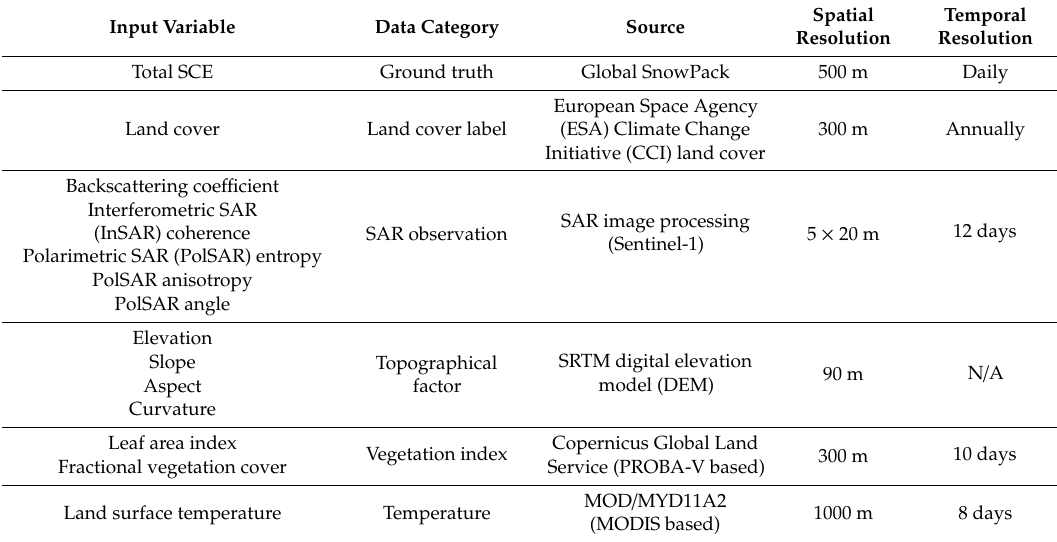
Table3. Attributesofinputdatawiththeirsource, spatialandtemporalresolution. NationalAeronautics and Space Administration (NASA)’s Shuttle Radar Topographic Mission, Moderate Resolution Imaging Spectroradiometer, and Project for On-Board Autonomy—Vegetation are abbreviated as SRTM, MODIS, and PROBA-V,